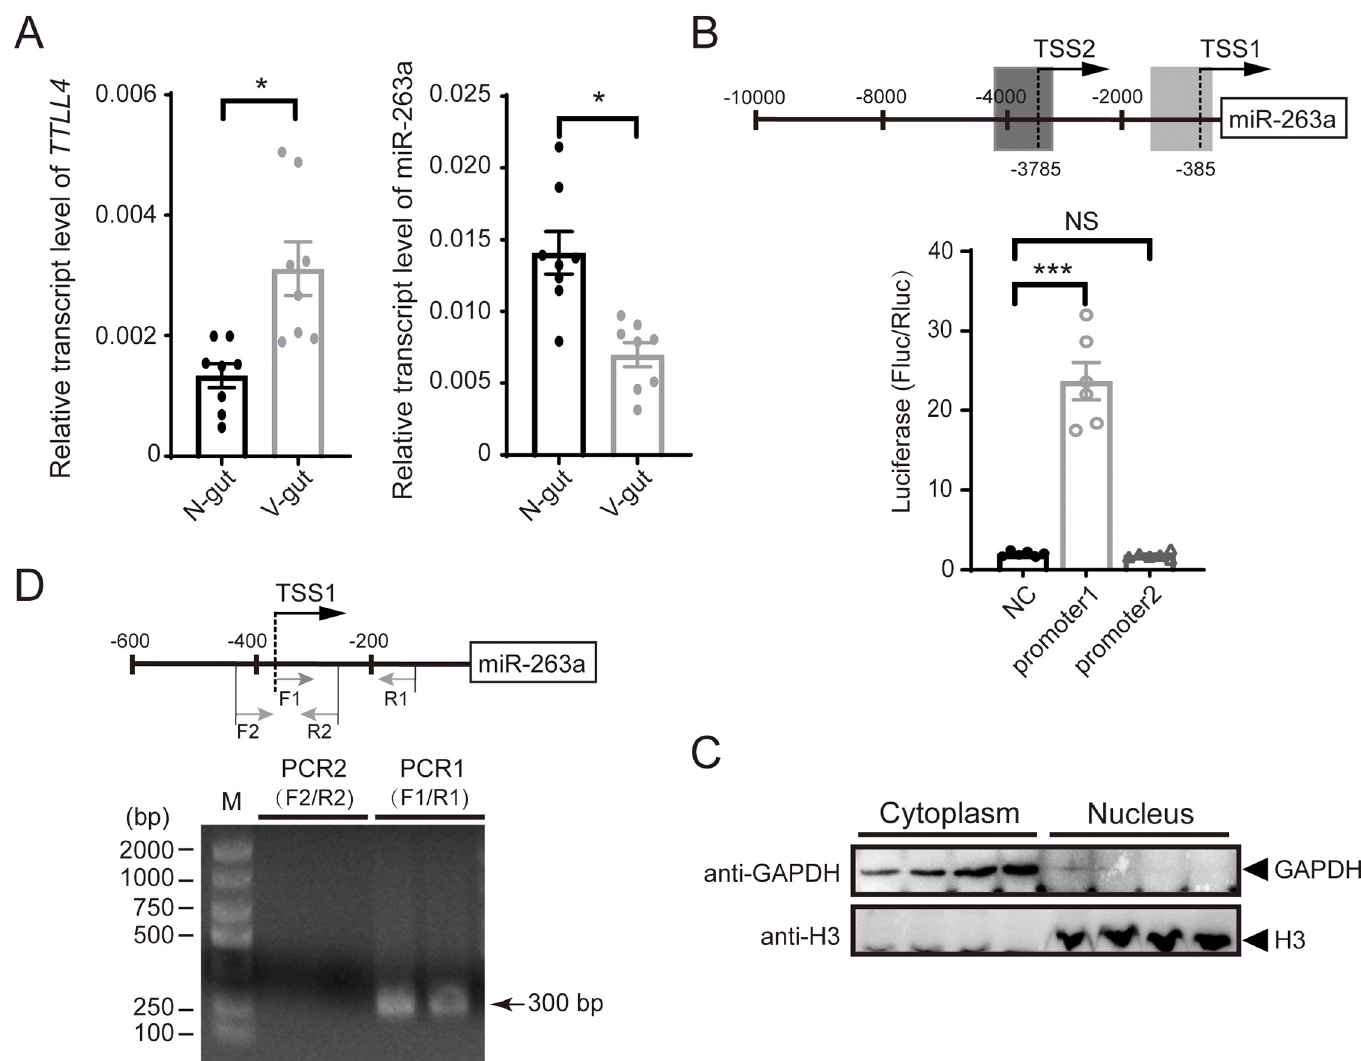
Fig 1. Determination of miR-263a promoter region. (A) Relative transcript levels of tubulin polyglutamylase ( TTLL4 ) and miR-263a in the gut of nonviruliferous (N) and viruliferous planthoppers (V) (n = 8). The planthopper EF2 gene and U6 snRNA were used as endogenous controls. (B) Promoter activity of recombinant pGL4.10 plasmids containing one of two putative promoter regions of miR-263a in human 293T cells in the dual luciferase reporter assay (n = 6). For (A) and (B), comparison was analyzed by Student’s t test. NS, no significant difference. � , P < 0.05. ��� , P < 0.001. The relative activity of firefly luciferase (Fluc) to Renilla luciferase (Rluc) is presented. Empty pGL4.10 was used as the negative control (NC). The schematic diagram shows two candidate transcription start sites (TSSs), from which putative promoter regions were cloned. The 5’ terminal nucleotide of mature miR-263a is designated as position +1. NS, no significant difference. Data in (A) and (B) show the mean values and standard errors and were compared by Student’s t test. (C) Western blot analysis of the nuclear and cytoplasmic extracts from viruliferous planthoppers. (D) Reverse transcription-PCR of the putative transcripts starting exactly from TSS1 or from 96 bp upstream of TSS1 with the cDNA template of the nuclear extracts. Two replicates are shown. Schematic diagram shows the positions of PCR primers. M,